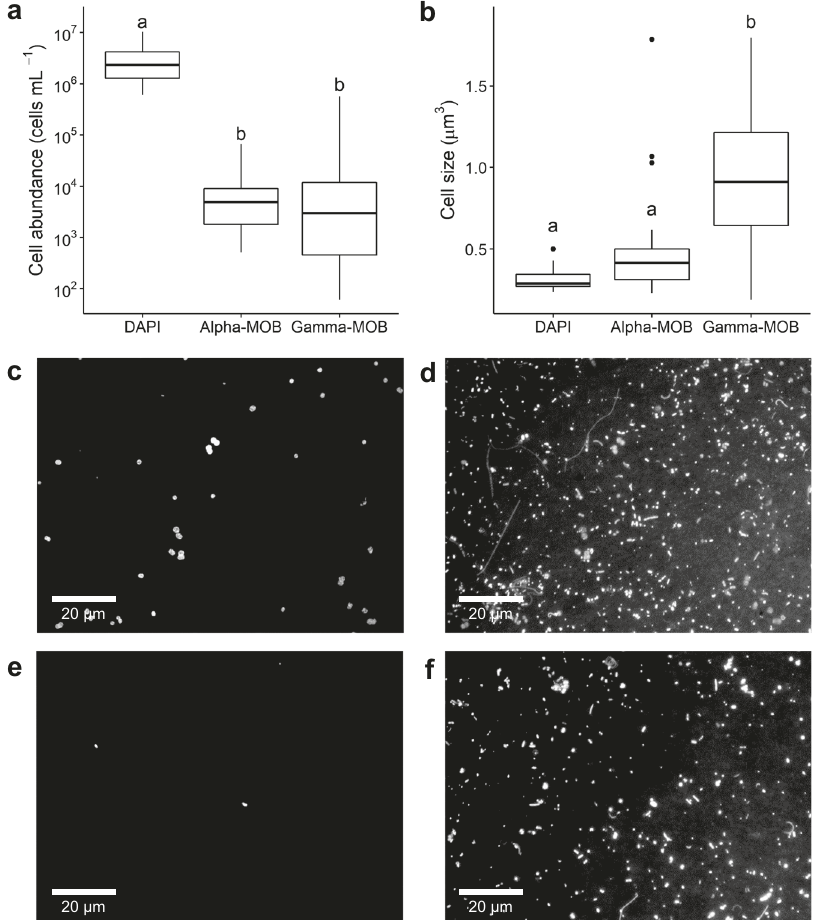
Fig. 1 Difference in the cell abundance and size of methanotrophic bacteria (Alpha-MOB and Gamma-MOB) and DAPI-stained prokaryotes across incubations with water from different depths in the six studied lakes. a Cell abundance across incubations (DAPI: n = 32, Alpha-MOB: n = 32, Gamma-MOB: n = 32). b Average cell size in each incubation (DAPI: n = 32, Alpha-MOB: n = 32, Gamma-MOB: n = 32). Boxplots show median, fi rst and third quartiles (hinges), and 1.5 x interquartile range (whiskers). Different letters indicate signi fi cant difference between means in a ( p < 0.001, ANOVA (F-value = 50.97) and p < 0.001, Tukey HSD) and in b ( p < 0.001, ANOVA (F-value = 35.48) and p < 0.001, Tukey HSD). c , d Microscopic picture of Gamma-MOB cells visualized by CARD-FISH and corresponding picture of the same fi eld of view showing all prokaryotic cells visualized by DAPI staining, respectively. e , f Microscopic picture of Alpha-MOB cells visualized by CARD-FISH and corresponding picture of the same fi eld of view showing all prokaryotic cells visualized by DAPI staining, respectively. White scale bars in c to f represent 20 μ m. Note log scale in y axis of a